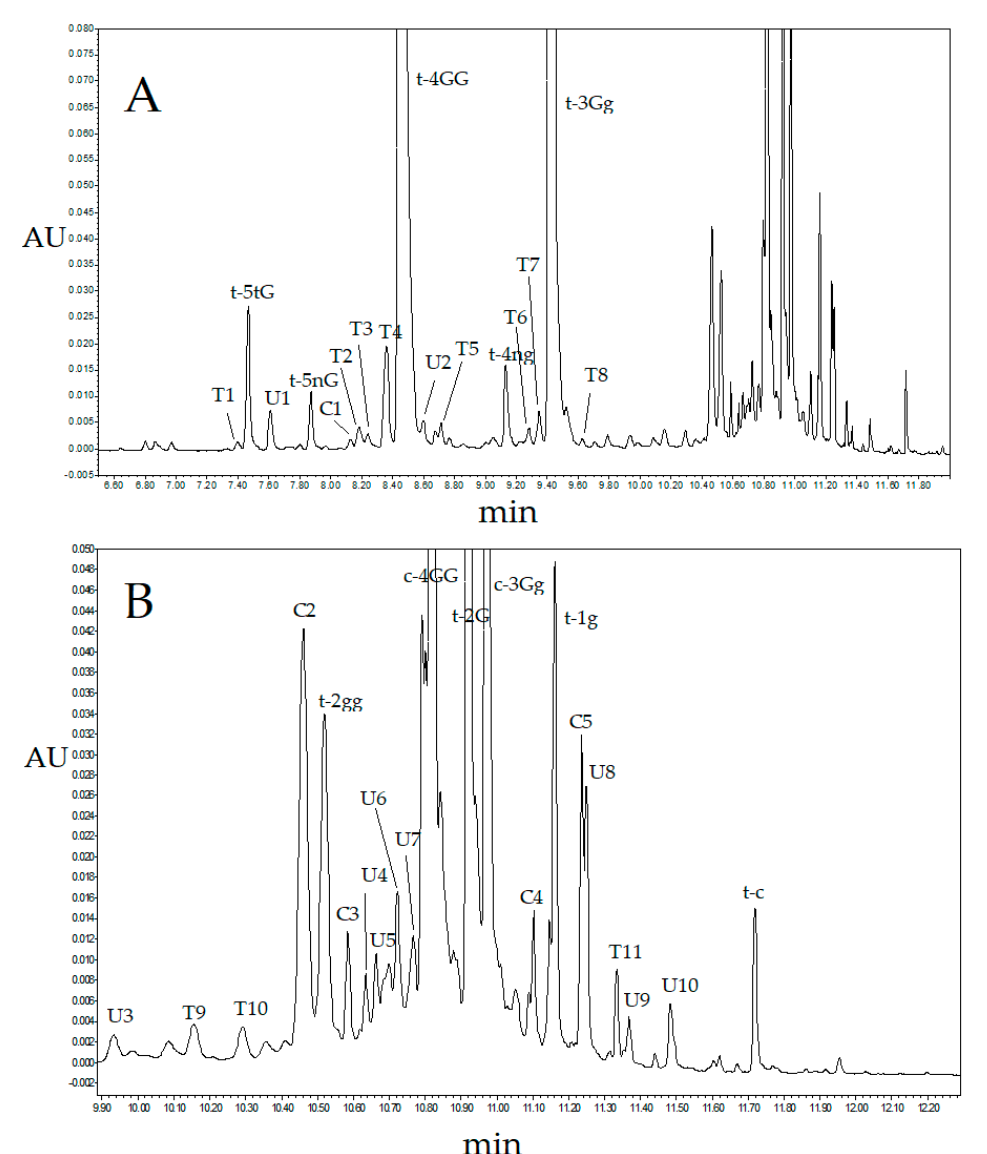
Figure 4. ( A ) Full UHPLC chromatogram detected at 440 nm of a saffron extract obtained with the column Luna Omega Polar C18 under the conditions described in Section 3.4 and ( B ) magnification of the last part of the chromatogram. Peak assignments are reported in Table 2.